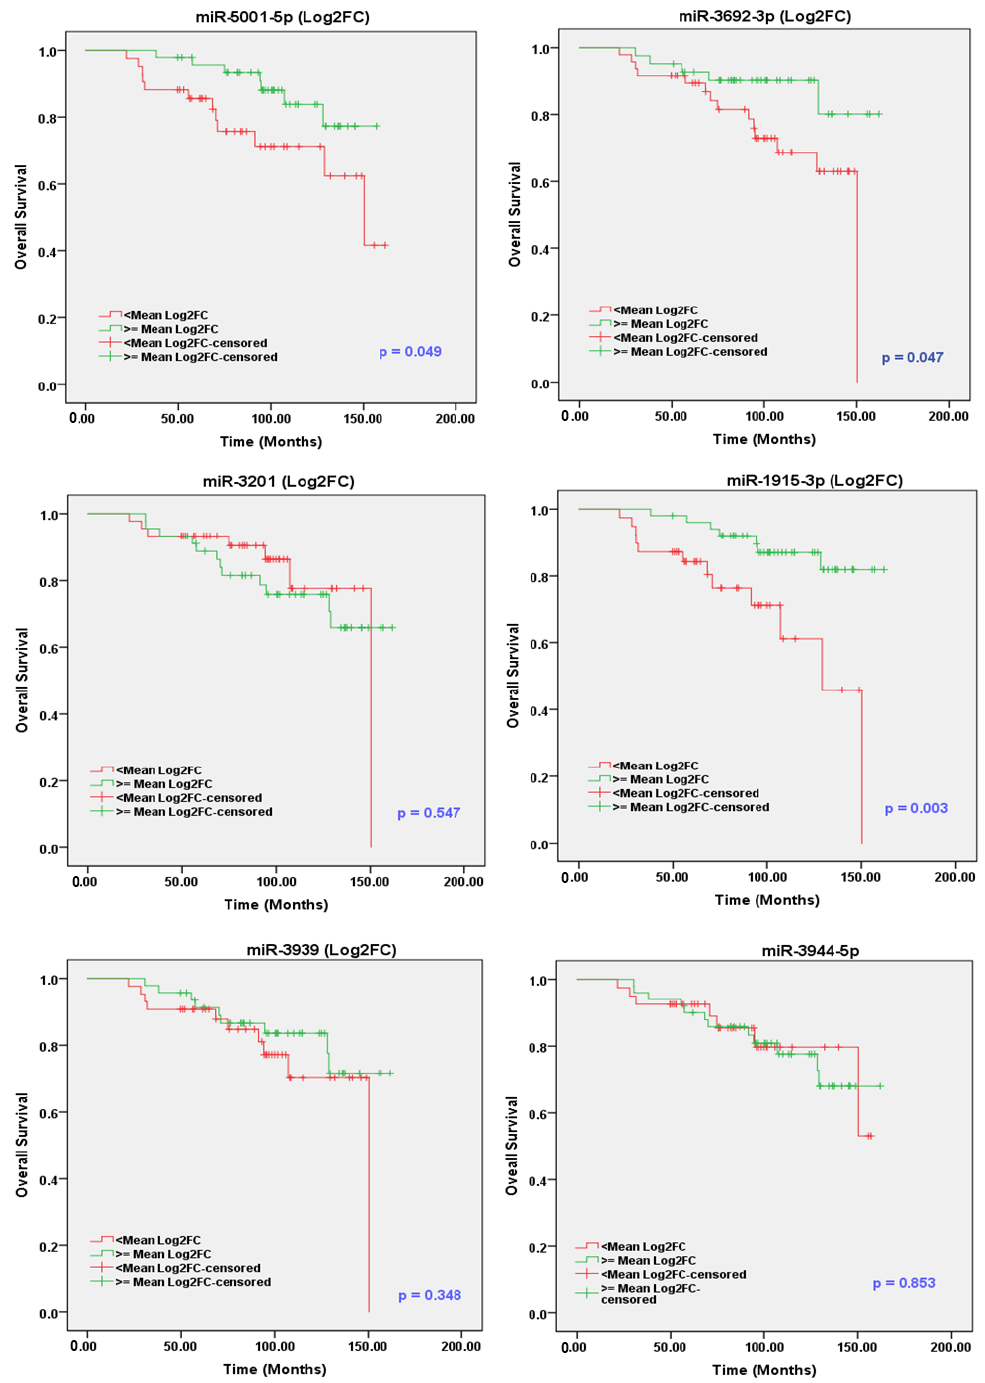
Figure 2. Overall survival analysis for PCa patients expressing high and low levels of sEV-associated miR-1915-3p, miR-3201, miR-3939, miR-3944-5p, miR-miR-3692-3p and miR-5001-5p in the NIH cohort. Kaplan – Meier analysis showing sEVs enrichment of miR-1915-3p, miR-3692-3p and miR-5001-5p is associated with better survival in PCa. The p -value was calculated by the log-rank test of the Kaplan – Meier curve.